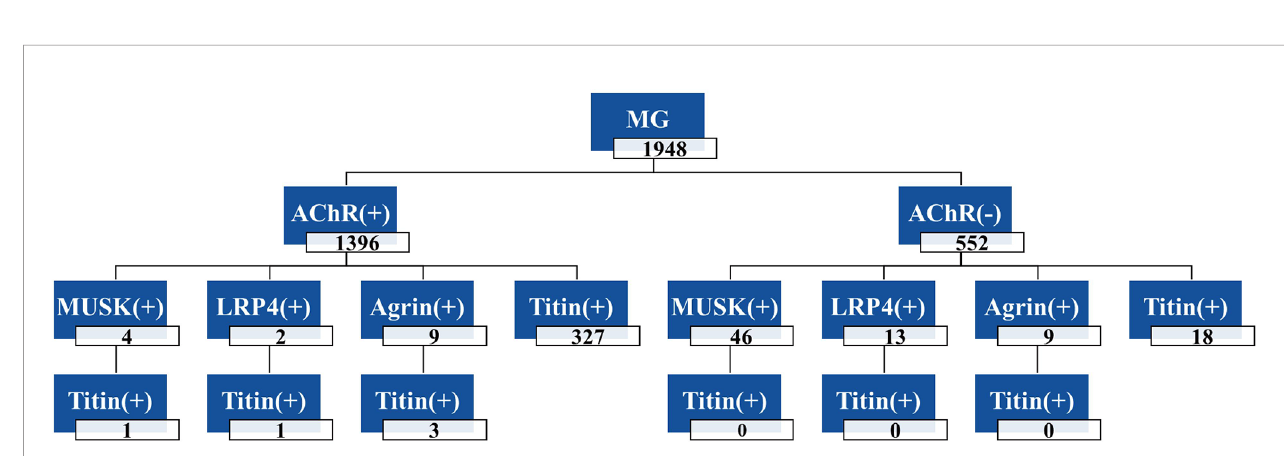
FIGURE 4 | Frequencies of antibodies in 1948 MG patients. The total number of MG patients was 1948, including 1396 AChR-Ab positive patients and 552 negative patients; Four patients were double-positive for AChR-Ab and MuSK-Ab, and one patient was triple-positive for AChR-Ab, MuSK-Ab and Titin-Ab. +, positive antibody; -, negative antibody.